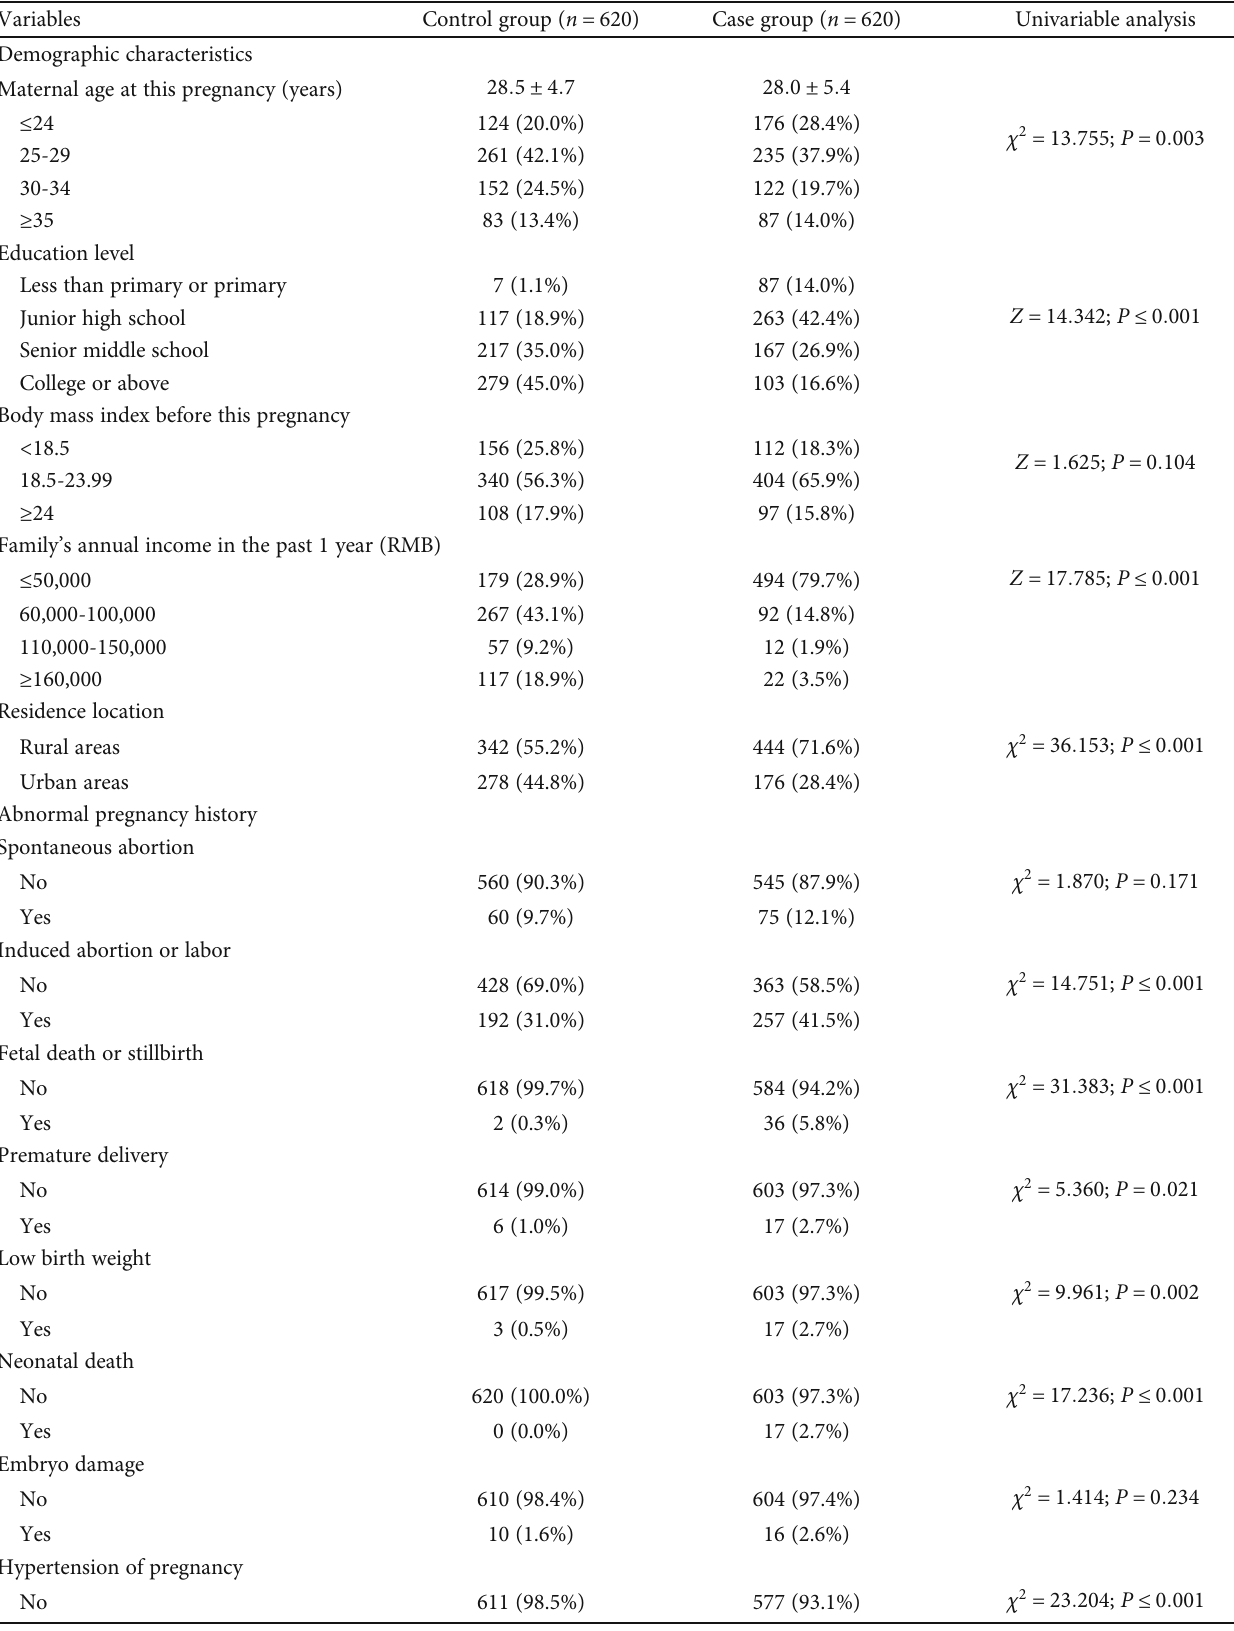
Table 1: Baseline characteristics comparison between control group and case